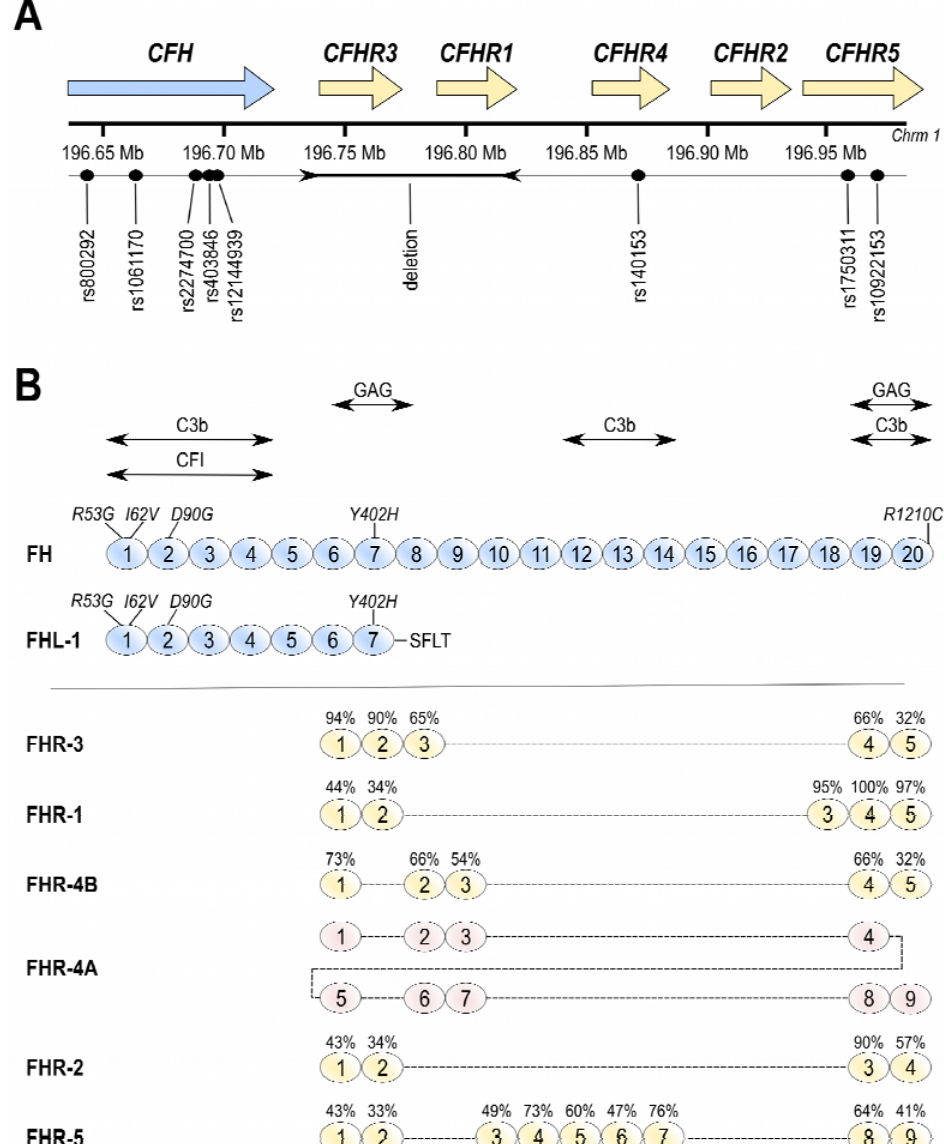
Figure 3. Complement factor H ( CFH ) and complement factor H related protein ( CFHR ) genes on chromosome 1 and the structures of FH, FHL-1 and FHR proteins. ( A ) The CFH and CFHR genes all occupy one stretch of chromosome 1 (1q32) known as the regulators of complement activation (RCA) cluster. The positions of some of the SNPs associated with AMD are shown; ( B ) A schematic diagram showing the twenty CCP domains of FH and the location of various ligand binding sites relevant to complement regulation. FHL-1, arising from a splice variation of the CFH gene, is identical to the first seven CCP domains before terminating with a unique C -terminal amino acid sequence of SFTL. The positions of coding variants in FH and FHL-1 associated with AMD are shown. FHR proteins 1–5 each share varying degrees of sequence homology to the FH protein, as indicated by a percentage above each domain. The identified alternative splice variant of FHR-4, known as FHR-4A, is also shown although it’s exact sequence and homology is still under